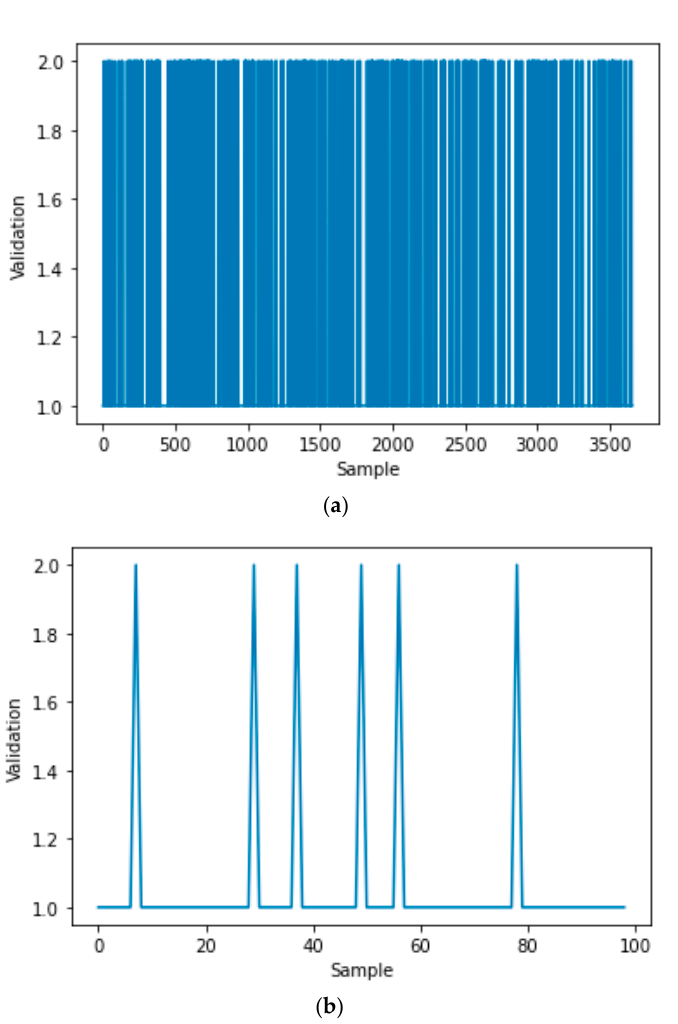
Figure 6. The output testing dataset of the decision tree: ( a ) all output of testing dataset, ( b ) zoomed in on a few samples from the output testing dataset.